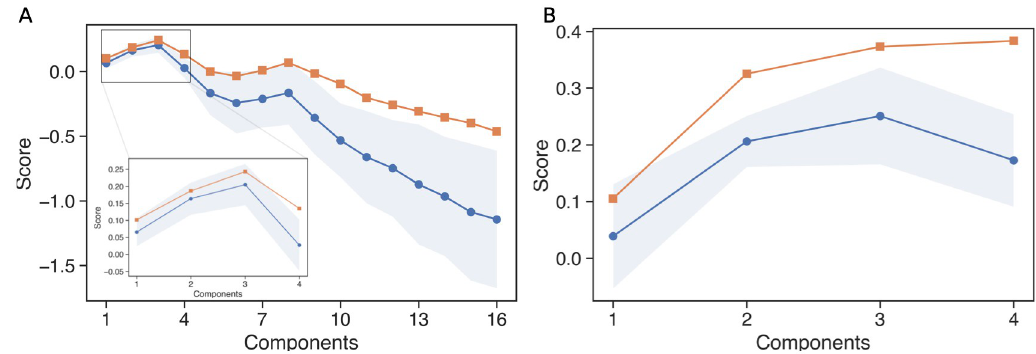
Fig 6. Scores obtained when different numbers of components are considered in the CCA. Panel A represents the scores for the CCA considering the data sets W and R while panel B shows the scores when using R and P . Note that only 4 components are considered for the latter because the DDM model only features 4 parameters. Blue traces depict the mean scores over the 4-fold cross-validation analysis (see Methods, Canonical Correlation Analysis) while the orange traces show the scores for the full data sets (no cross-validation analysis performed). The shadowed blue zone corresponds to the standard deviation of the scores in the cross-validation